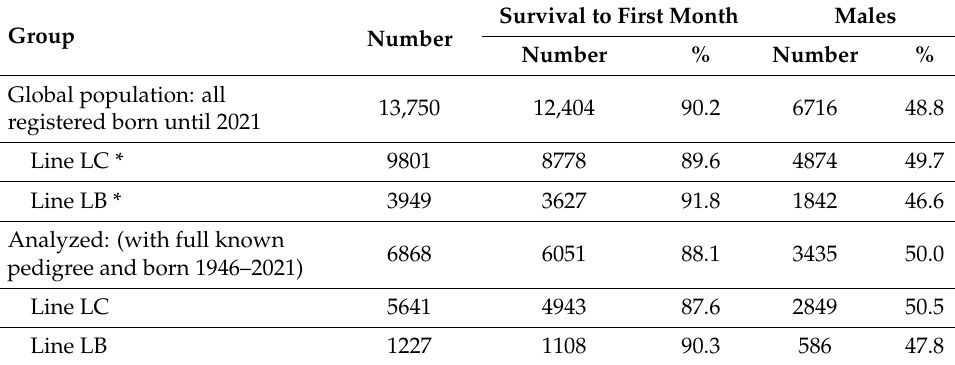
Table 1. The number of European bison registered in EBPB up to 2021 and analyzed with information about survival to first month of age and the proportion of